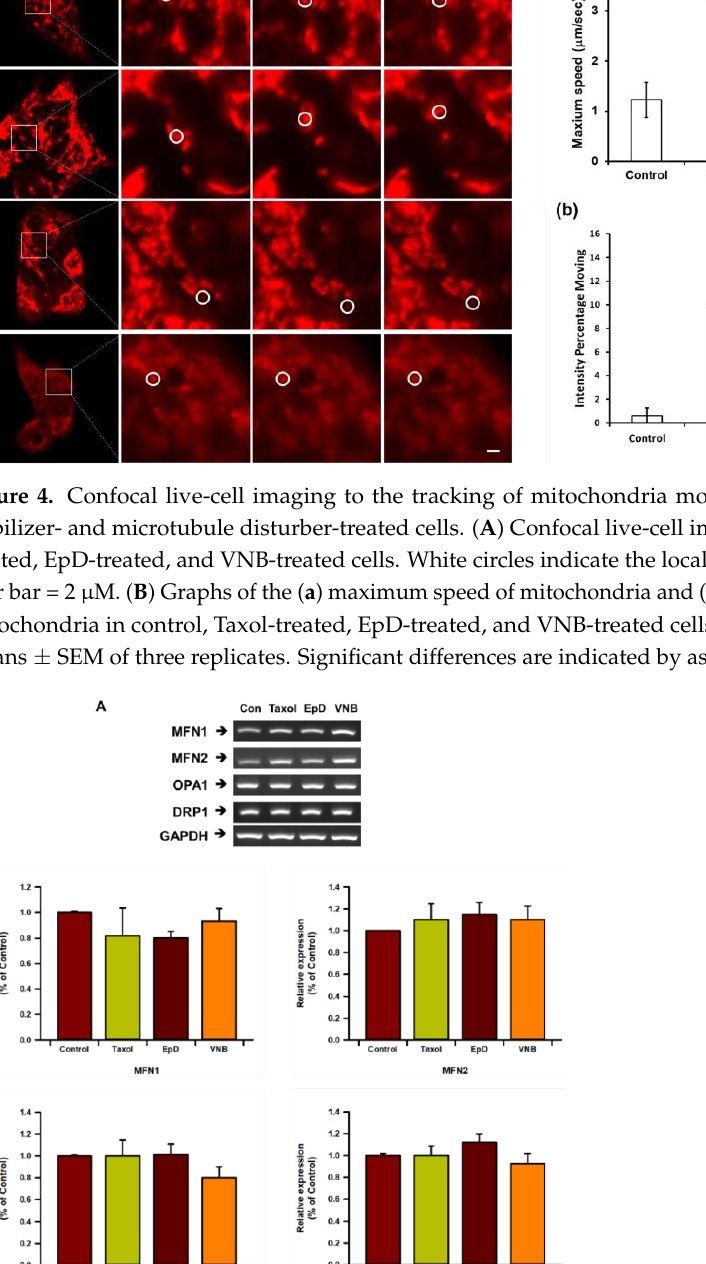
Figure 5. Gene expression analysis of MFN1, MFN2, OPA1, and DRP1 in microtubule stabilizer- and microtubule disturber-treated cells. ( A ) RT-PCR analysis. ( B ) Real-time qPCR analysis. Data are presented as means ± SEM of three replicates.